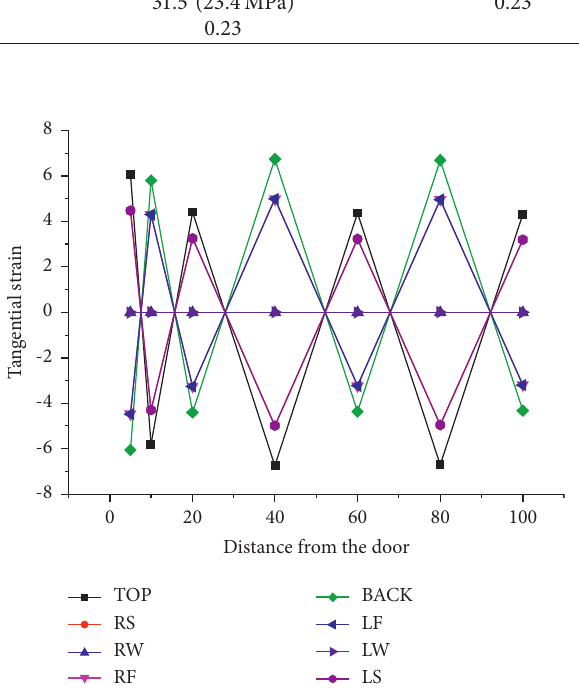
Figure 7: The influence of tunnel opening distance.